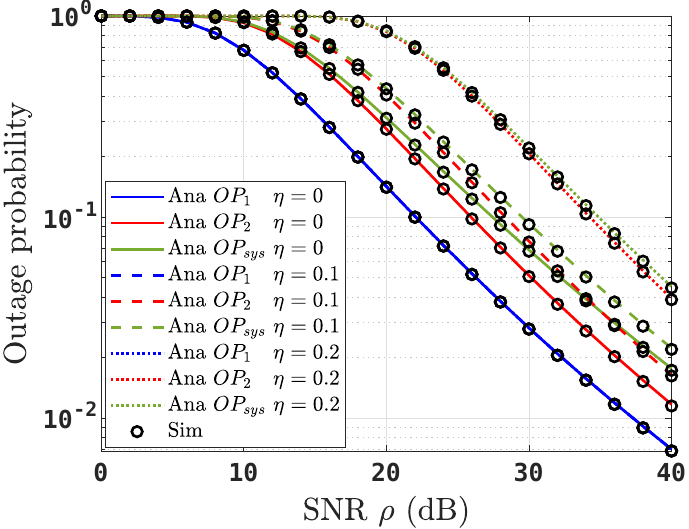
Figure 4. OPs versus SNR for thermally uniform salty UOWC links at BL = 2.4 L/min for varying values of η .